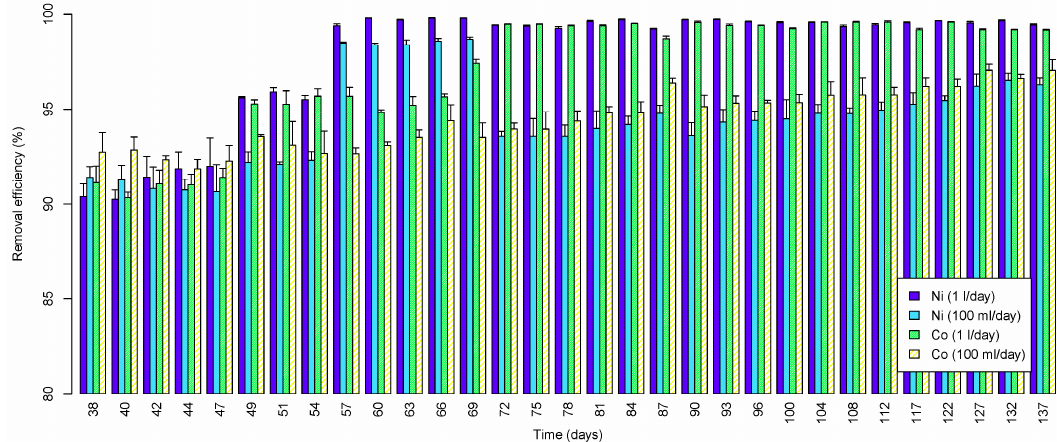
Figure 5. Ni and Co removal efficiency (%) using spent Agaricus bisporus as a function of reactor operation time.